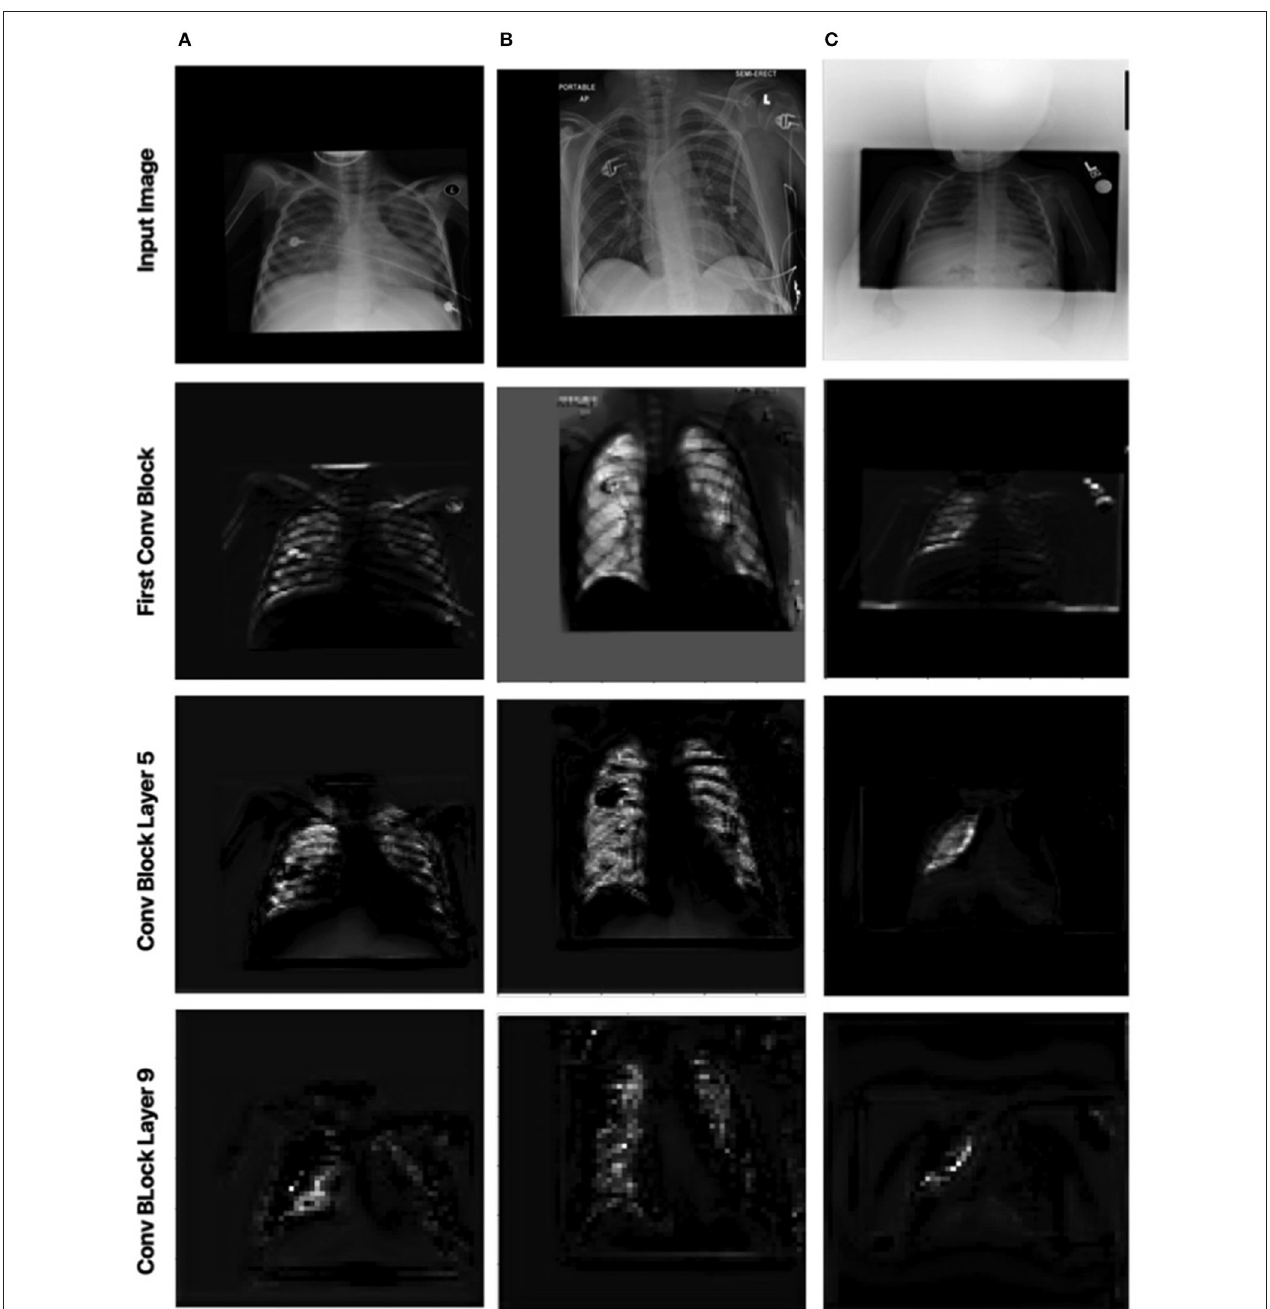
FIGURE 7 | Impact of MEDUSA local attention on the images with distortion. Columns 1, 2, and 3 correspond to images (A–C) in Figure 5 , respectively.